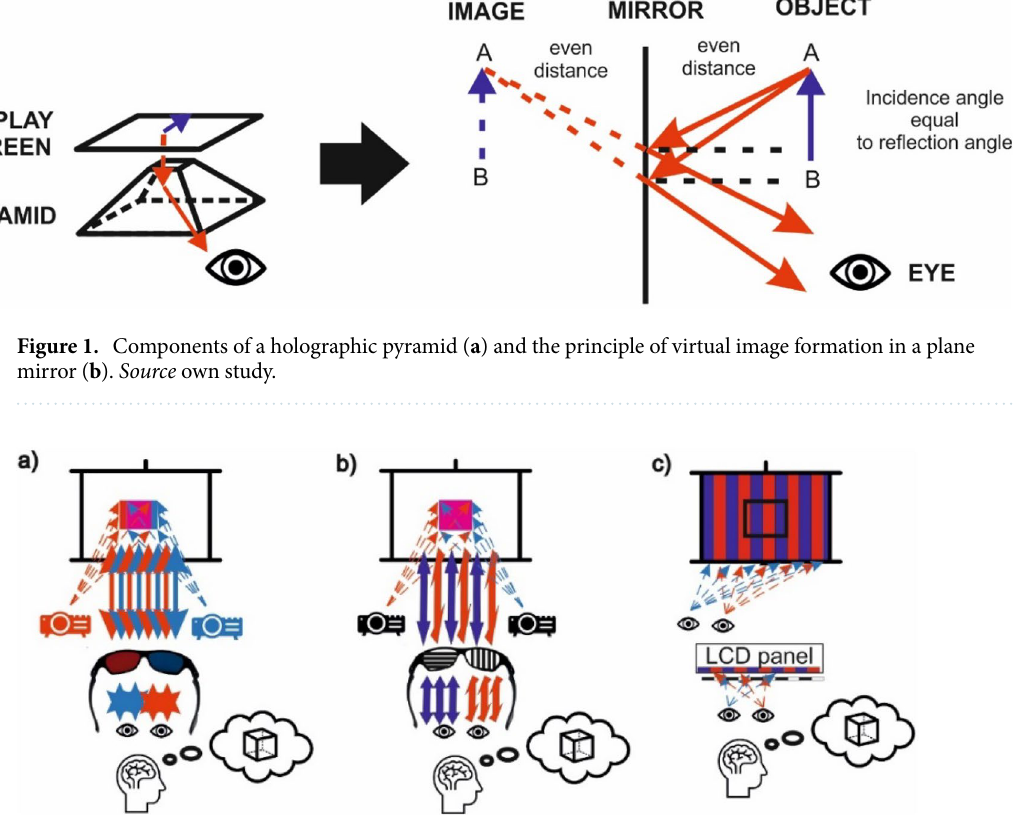
Figure 2. 3D visualisations using the hologram technique: ( a ) anaglyph, ( b ) polarising filters, ( c ) 3D matrix. Source own